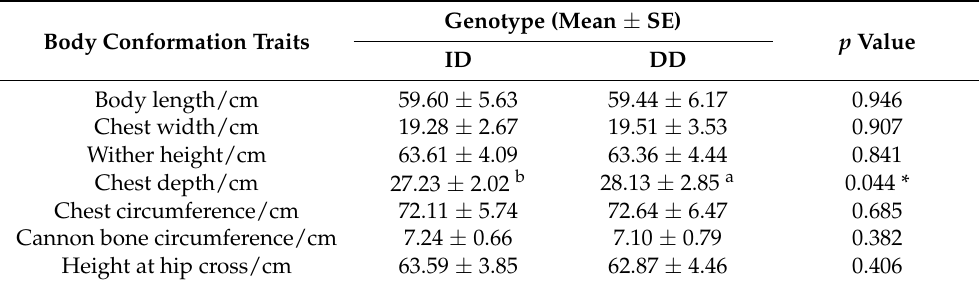
Table 4. Association analysis of LRRC8B gene polymorphism and body conformation traits in Small-Tailed Han